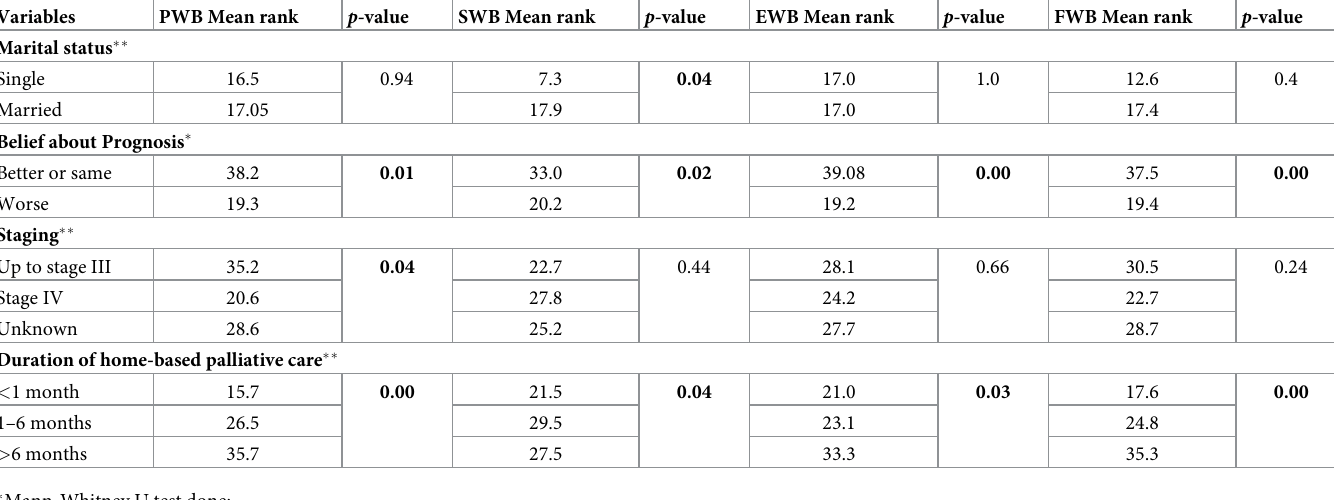
Several studies found a significant relationship between self-dependency and quality of life, although no relationship between these two variables was found in this study [21]. It had also been observed by Peters and Sellick that patients getting home-based care had better symptom control and self-dependency than those receiving institution-based care [7]. Nevertheless, our study made no comparison between home-based and institution-based care. Table 4. Relationship of sub-domains of quality of life (QoL) with different variables (n = 51). Variables